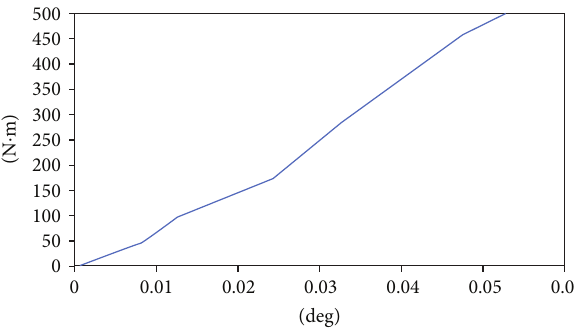
Figure 8: Rotational stiffness curve (around 𝑥